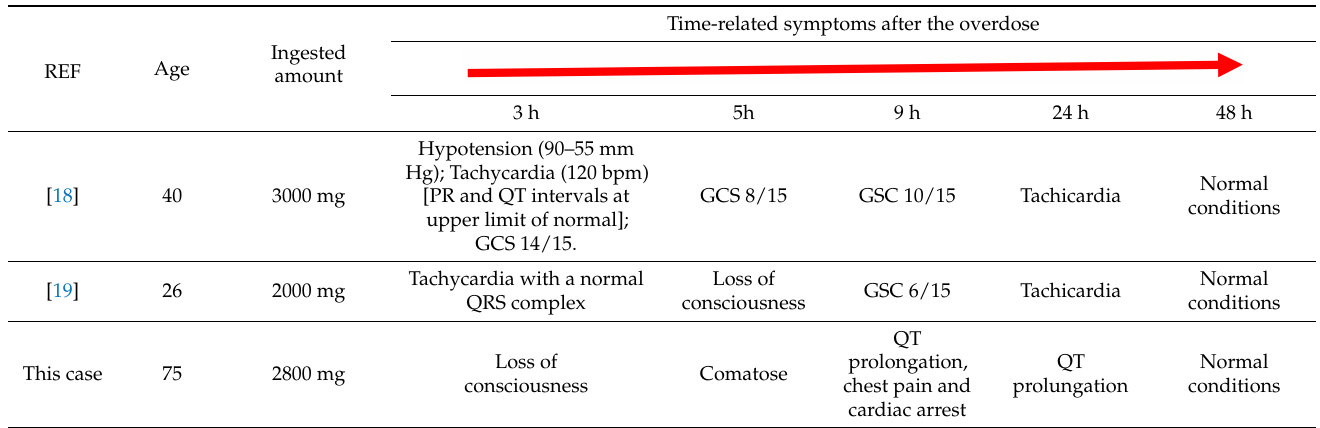
Table 3. Quetiapine’s overdose symptoms described by Pollak [18] and Harmon [19], and of our